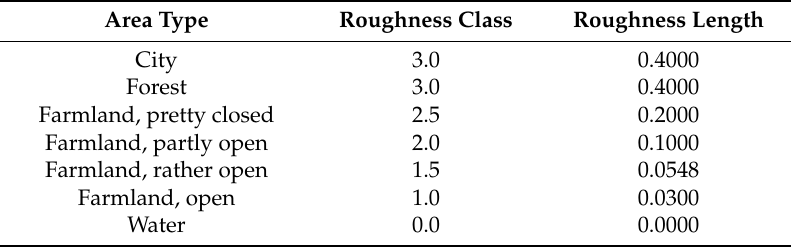
Table 2. The values of roughness class and length [35].